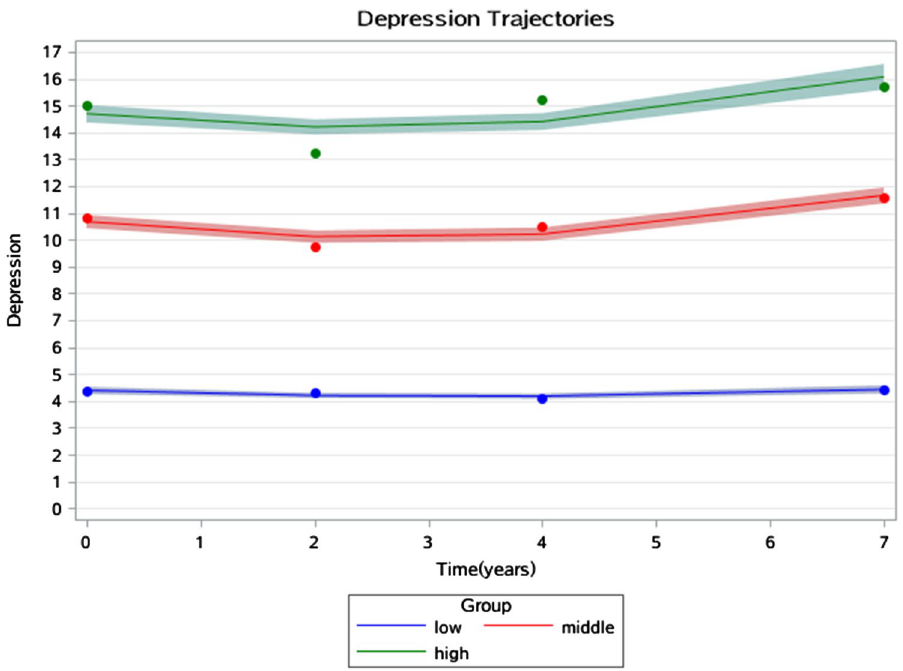
Figure 3. Depression trajectories among a sample of older individuals that survived a 7-year period in China.